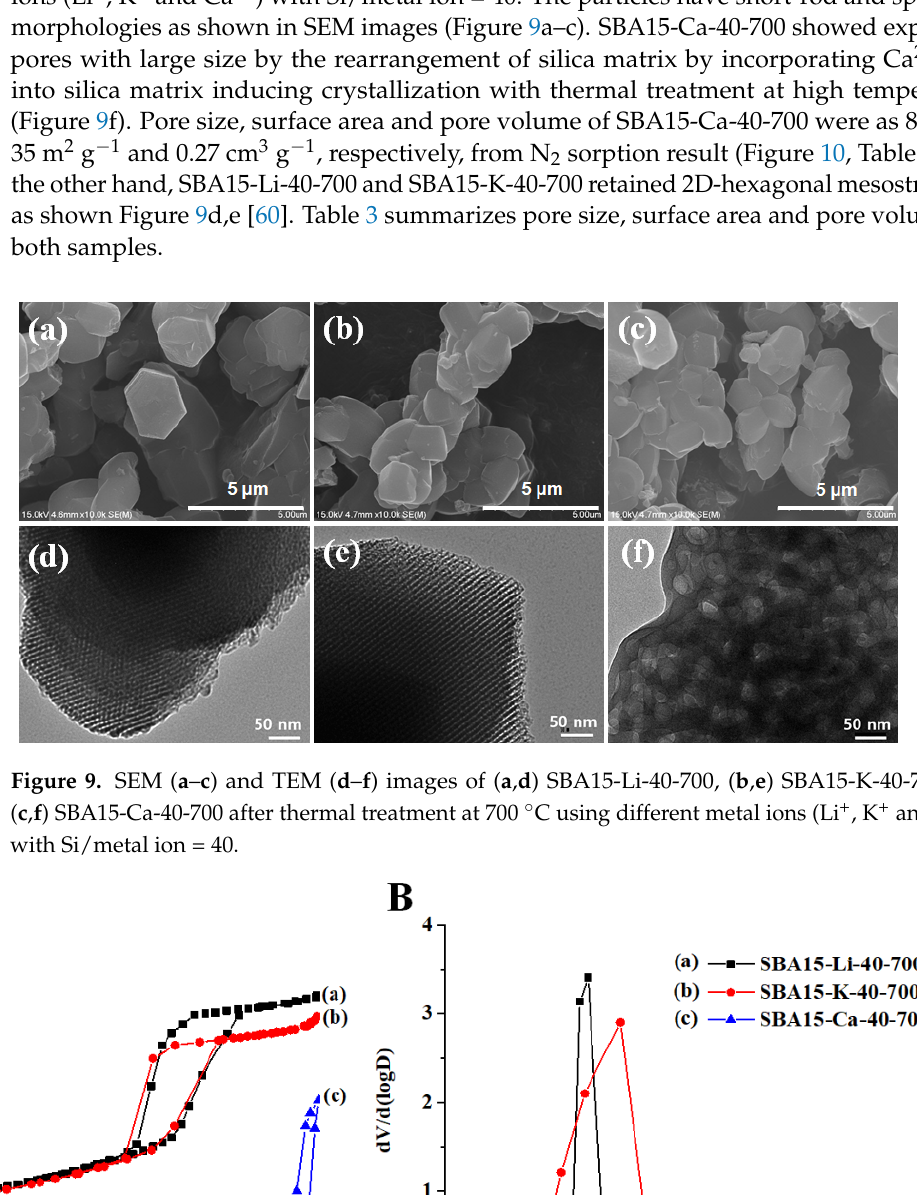
Figure 8. XRD patterns in the range of low angle (2θ = 1.2 – 6°) ( A ) and wide angle (10 – 80°) ( B ) of (a) SBA15-Li-40-700, (b) SBA15-K-40-700 and (c) SBA15-Ca-40-700 after thermal treatment at 700 °C using different metal ions (Li + , K + and Ca 2+ ) with Si/metal ion = 40.